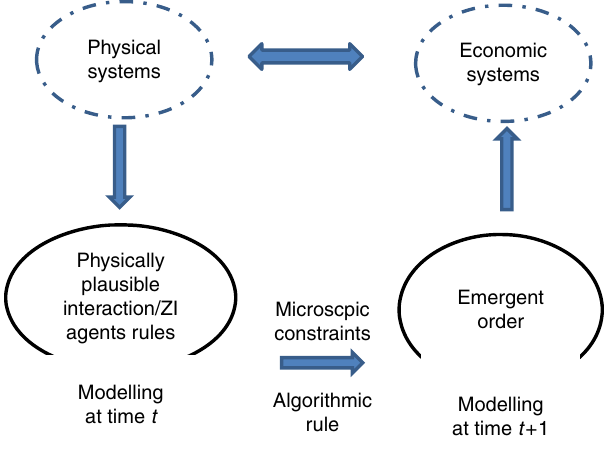
Figure 3. Bottom-up